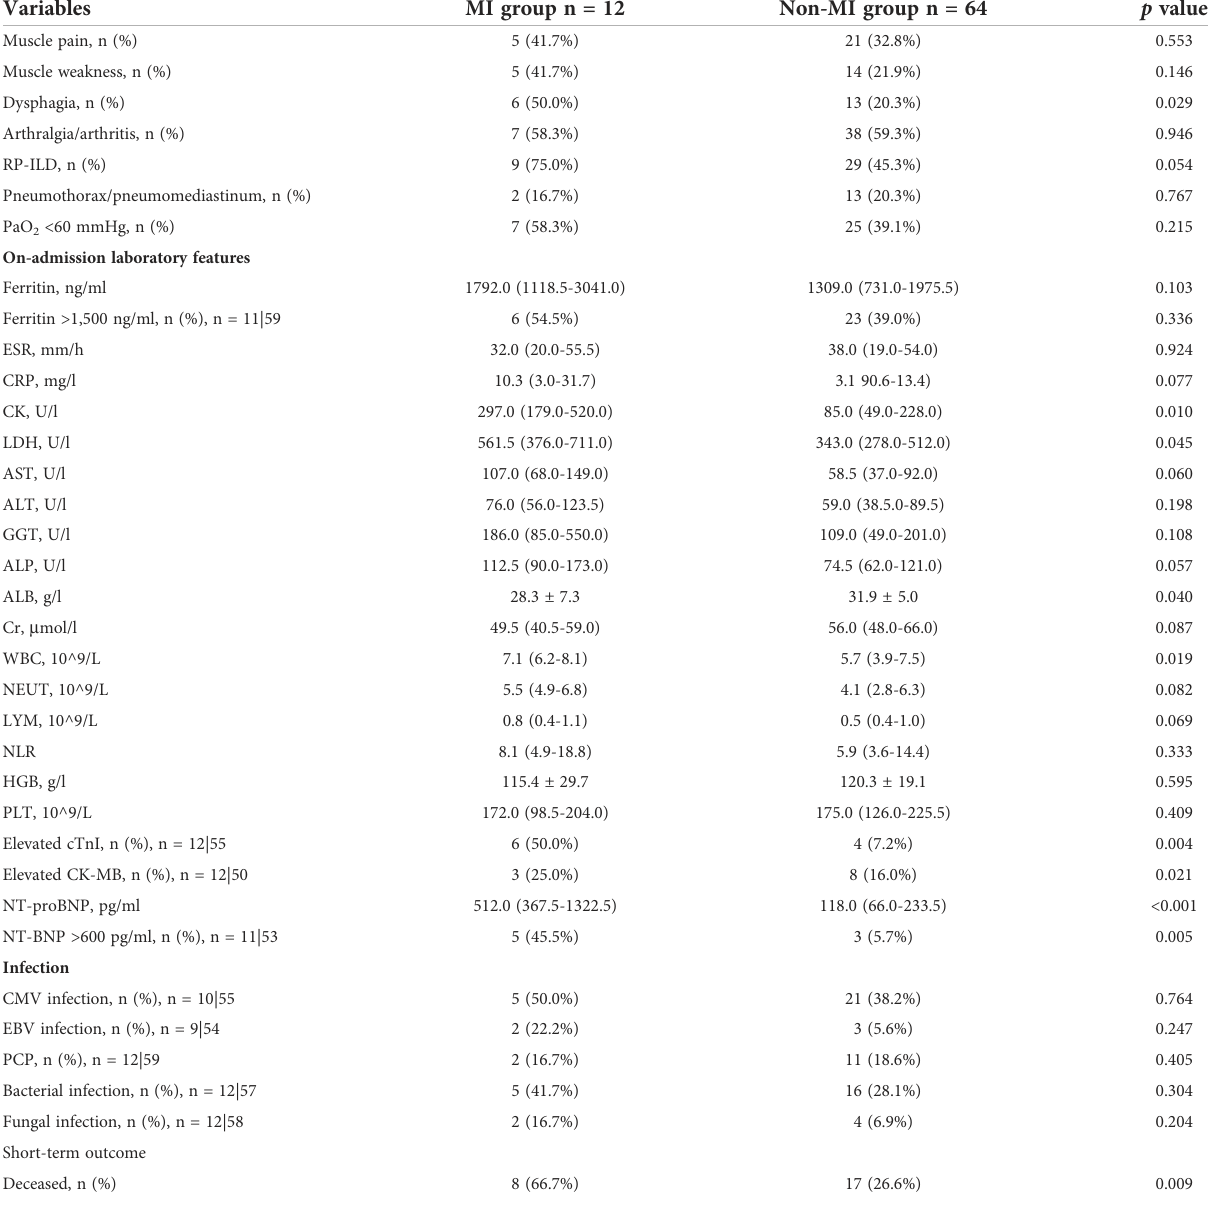
compared with the survival group. Levels of in fl